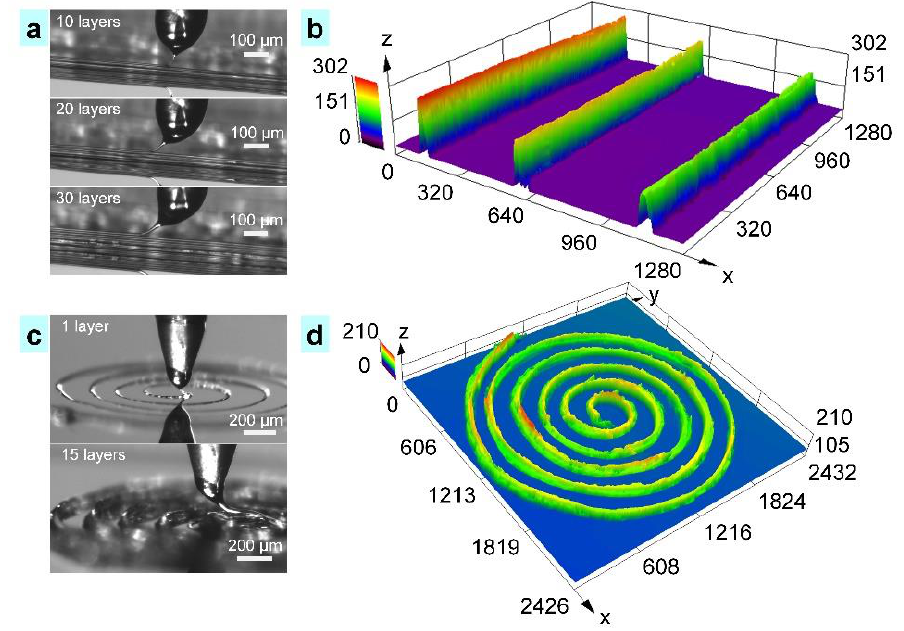
Figure 6. TVEJ printing of 3D structures with varying aspect ratio and desired interlaminar bonding. ( a ) The printing process of perpendicular walls with 10, 20, and 30 layers and its interlaminar bonding; ( b ) 3D profile of the perpendicular walls (unit, µm); ( c ) Fabricating process of a 3D spiral structure in continuous printing sequences; ( d ) 3D profile of a spiral structure (unit, µm).